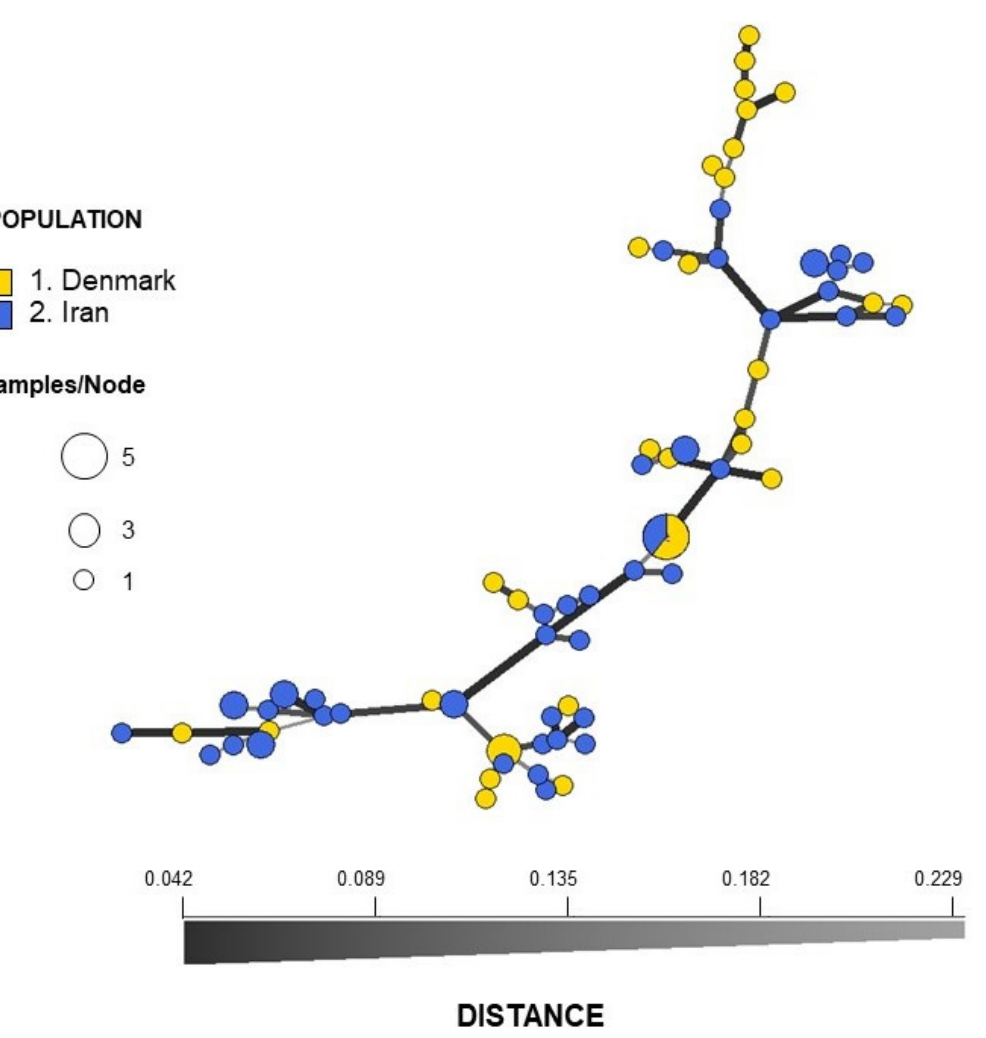
Figure 1. Minimum spanning network (MSNs) inferred using STRs from Danish (blue) and Iranian (yellow) isolates of Candida parapsilosis . The network is based on Bruvo’s distance matrix. Each node represents a multi-locus genotype (MLG), with variable size depending on the number of individuals within that MLG. The distance between the nodes represents the genetic distance between MLGs.